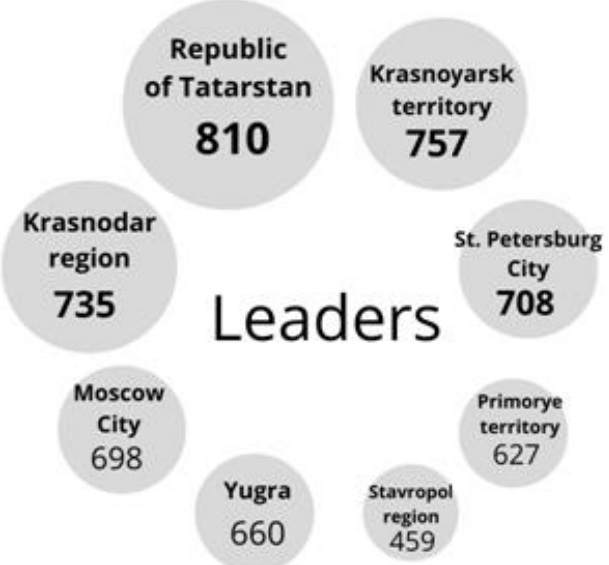
Figure 5. Leading regions in terms of aggregate scores for assessing the popularity of thematic